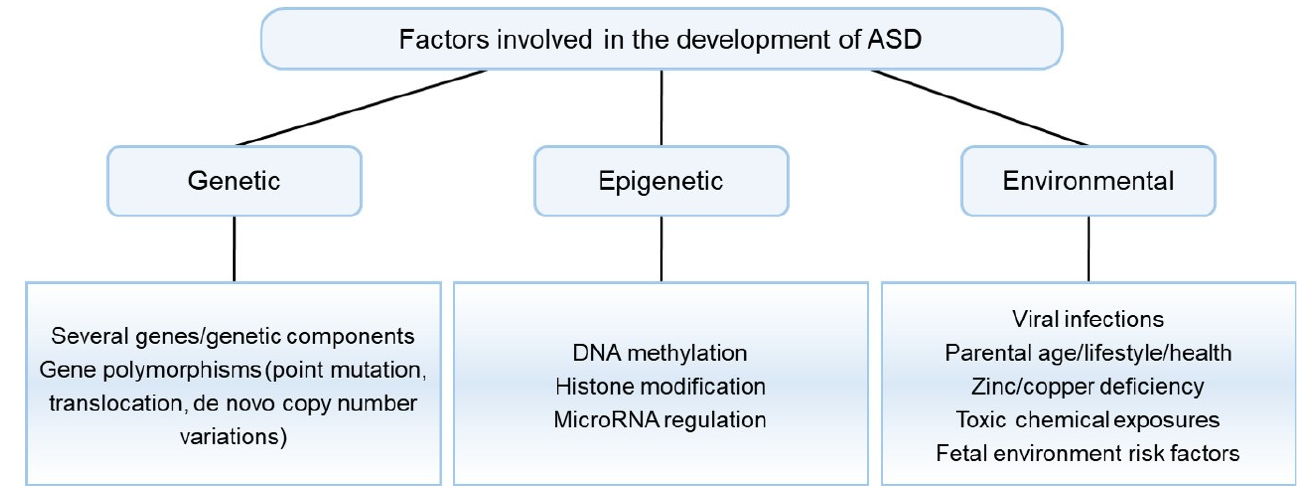
Figure 1. Factors involved in the development of autism spectrum disorder (ASD).